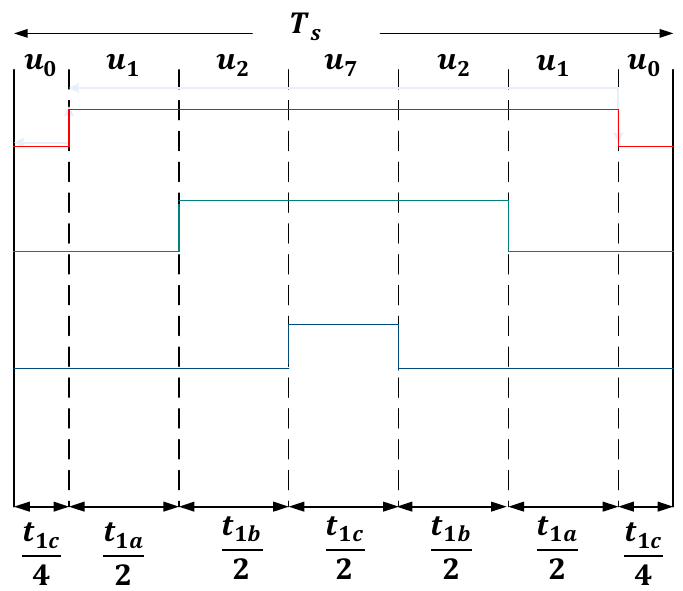
Figure 7. Switching Pattern of voltage vectors for sector 1. Electronics 2021 , 10 , x FOR PEER REVIEW